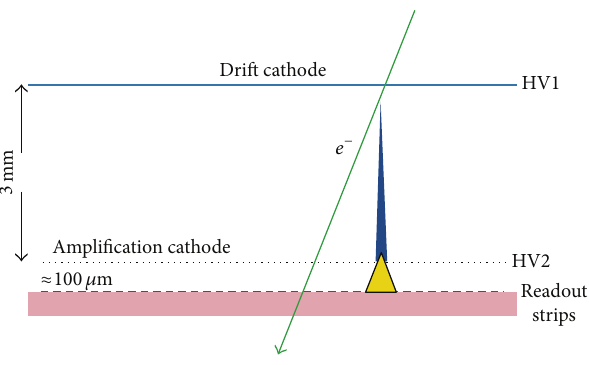
Figure 3: Schematic of the principle of operation of a Micromegas detector showing an incoming charged particle ionising the gas and leaving a signal on the readout strips.